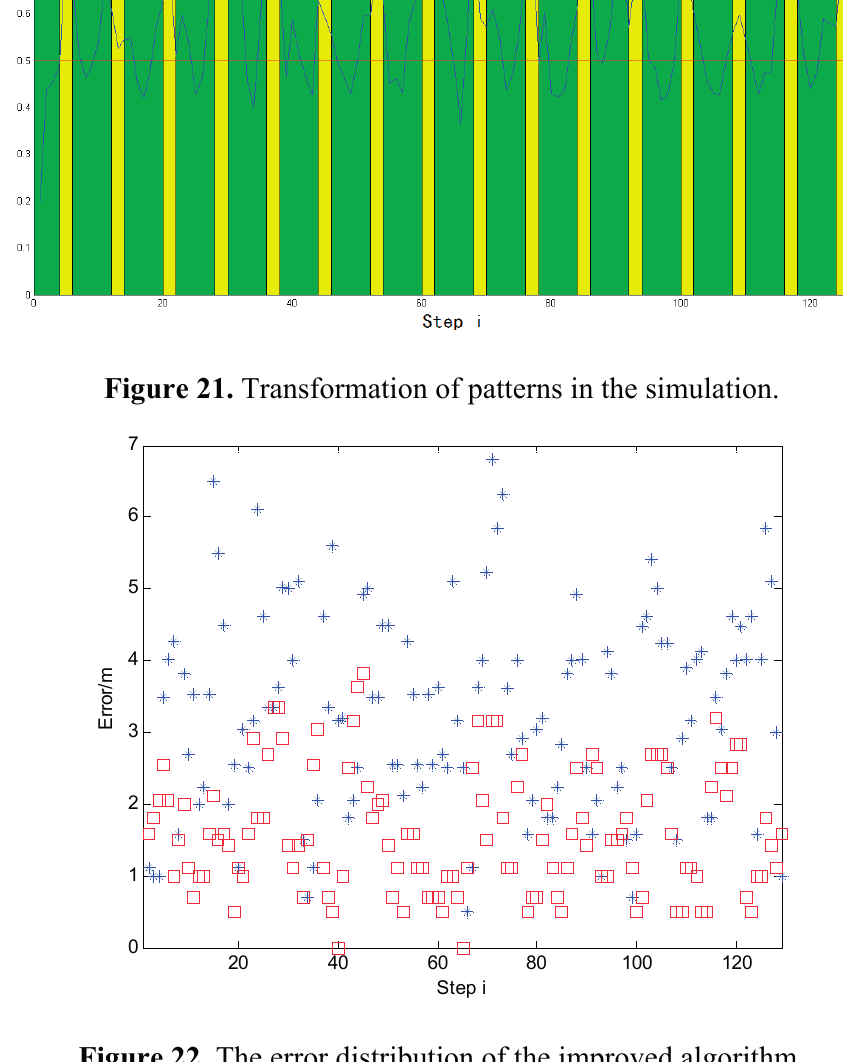
Figure 22. The error distribution of the improved